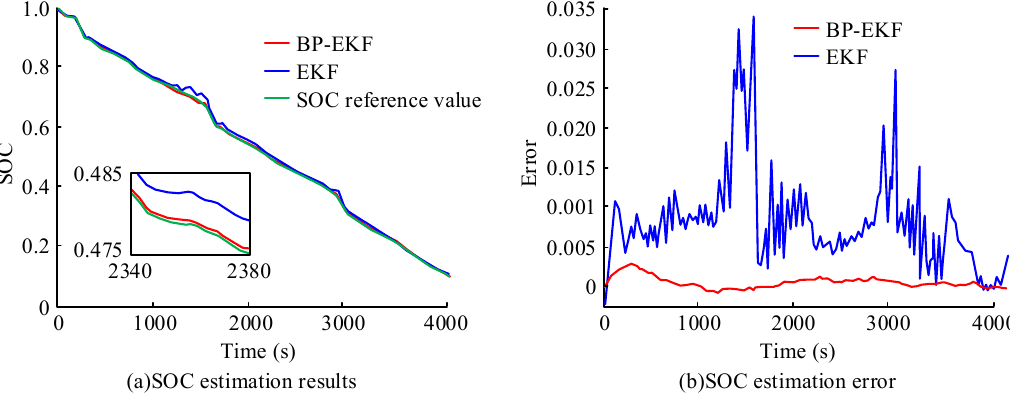
Figure 7. SOC estimation results and errors of model battery under UDDS conditions. As can be seen from Figure 7, the model converges quickly to the true value in the UDDS condition, and the difference between the appraised SOC and the true value is small. Compared with the constant current discharge condition and the pulse discharge condition, the estimation error of the model under UDDS condition increases slightly, but still maintains a good estimation accuracy. The BP-EKF model was compared with the unscented Kalman filter (UKF) model and the EKF model, and the absolute value of the estimation error of the E-cell SOC for the DST condition is shown in Figure 8.